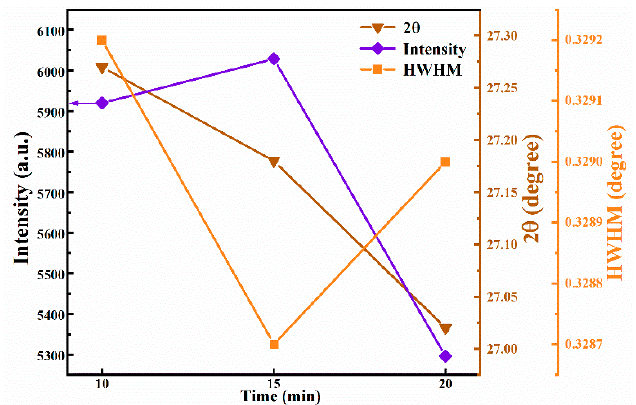
Figure 3. Curves of the 2 θ , peak intensity, and FWHM of (112) peaks for the CNZTSSe films with the selenization time.